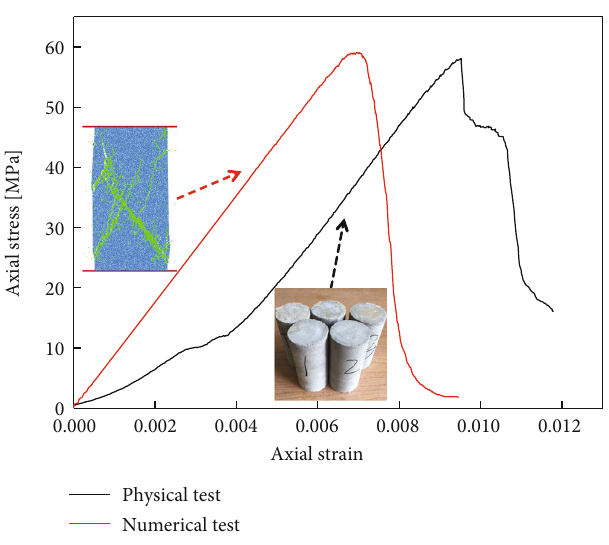
Figure 2: Numerical model of joint sample established by the MSJM.